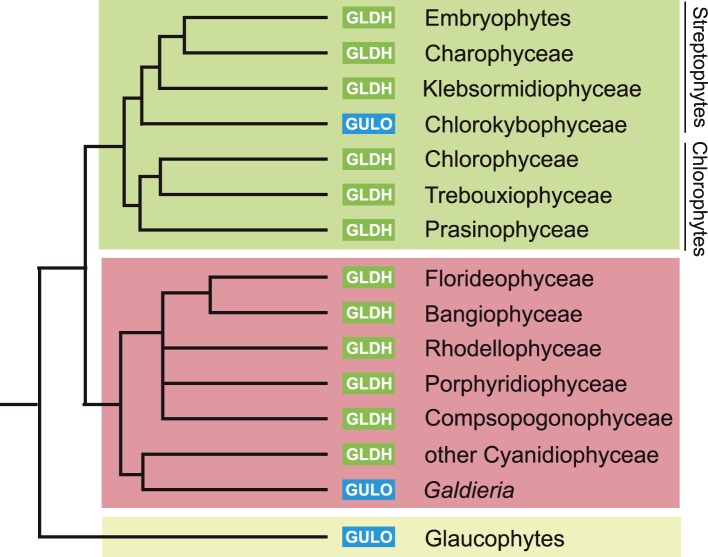
Distribution of GULO and GLDH in the Archaeplastida.A schematic tree demonstrating the currently accepted phylogenetic positions of the major lineages in the Archaeplastida (Yoon et al., 2006; Leliaert et al., 2012). The presence of either GULO or GLDH in representatives of each lineage is shown. The boxes denote the Viridiplantae (green), Rhodophyta (red) and Glaucophyta.